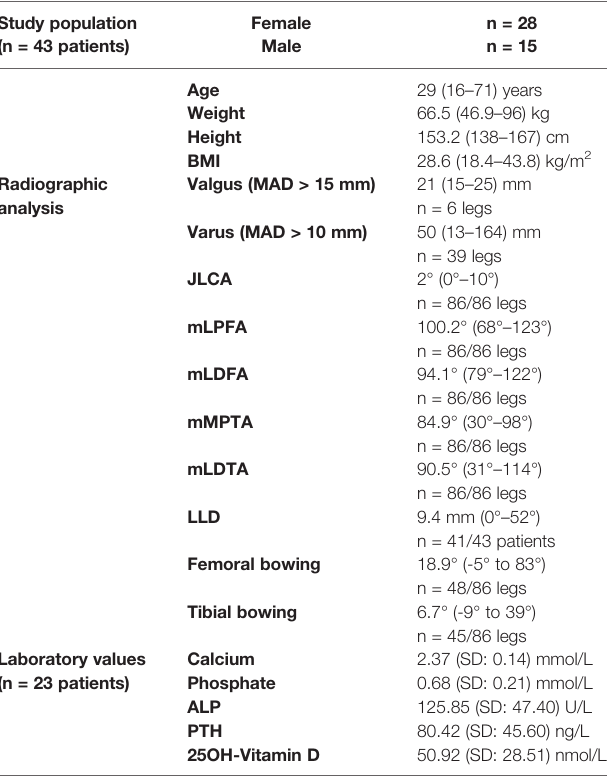
TABLE 1 | Demographic data of the study population including mean age, weight, height, and BMI and ranges (min – max) inside the brackets. Study population (n = 43 patients)